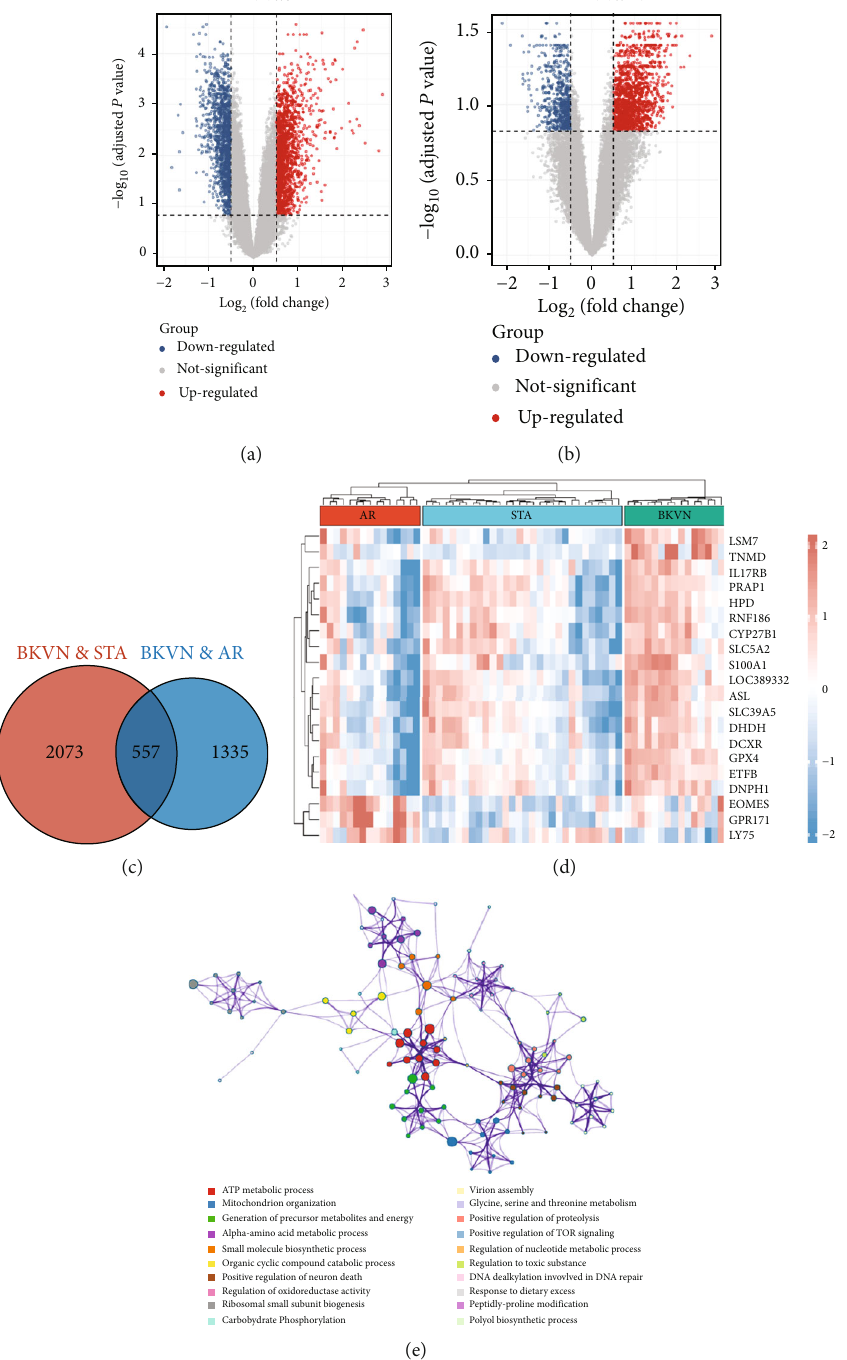
Figure 3: Identi fi cation and functional enrichment analysis of DEGs. (a and b) Volcano plot shows DEGs in BKVN samples compared with STA and AR samples, respectively. Blue dots denote downregulated genes, grey dots denote genes without signi fi cant di ff erences, and red dots denote upregulated genes. (c) Venn diagram for common DEGs; the red and blue circles represent DEGs in BKVN samples contrasted with STA and AR samples, severally. (d) Heat map for the expression levels of 20 top-ranked DEGs in AR, STA, and BKVN samples. (e) Network of top 20 enriched clusters, where each node represents one statistically signi fi cant term and terms with similarity of more than 0.3 are connected by